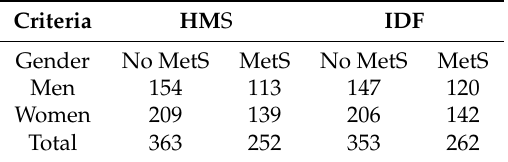
Table 5. Relationship between IDF and HMS in the